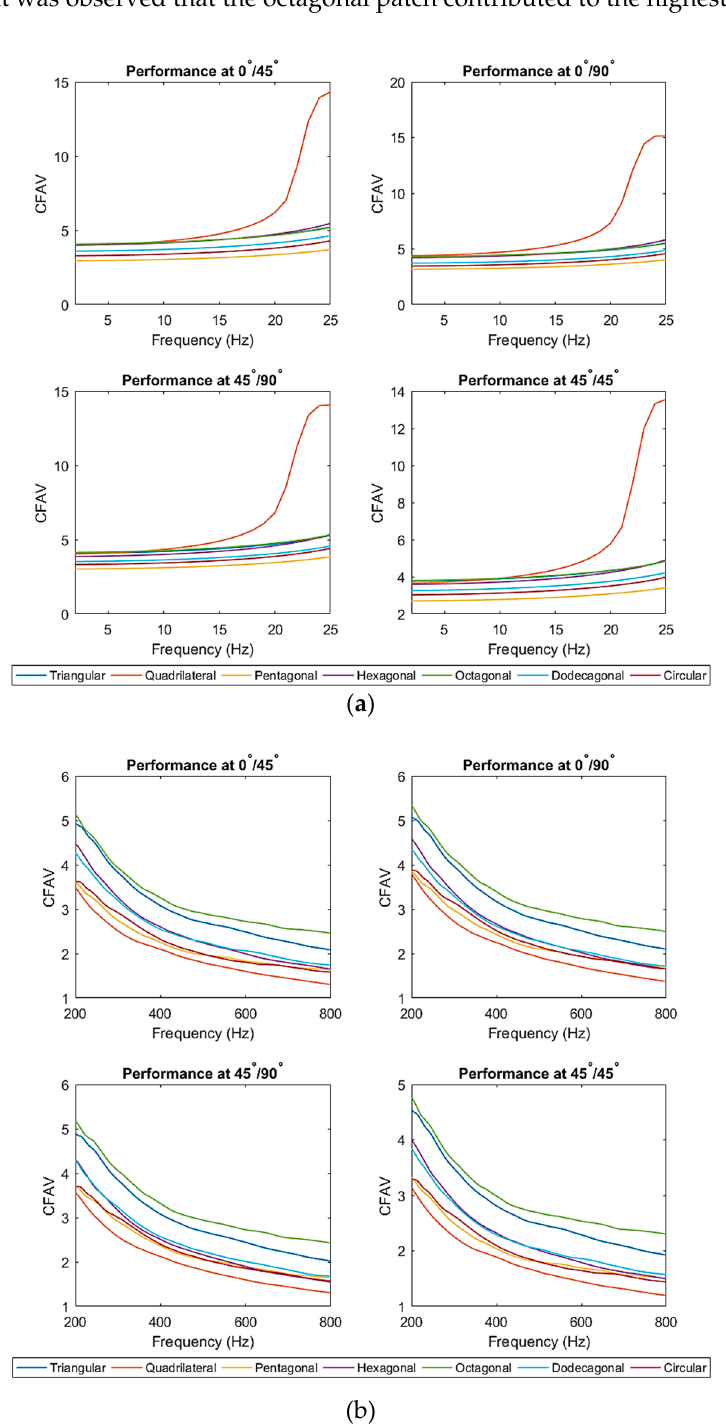
Figure 13. Performance ( a ) frequencies below 25 Hz range ( b ) broadband frequency ranges for dou- ble-lamina. Figure 14 represents the plots for the normalized maximum CFAV for the single and double-lamina composites, where the variation in performance at different frequency